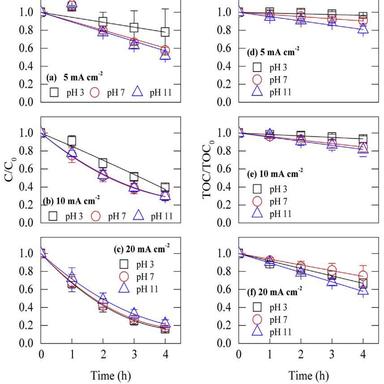
PRED degradation (a, b and c) and mineralization (d, e and f) for all experimental conditions. EAO conditions: 50 mg L1 of PRED, 1 g L1 of Na2SO4, room temperature and no pH control.